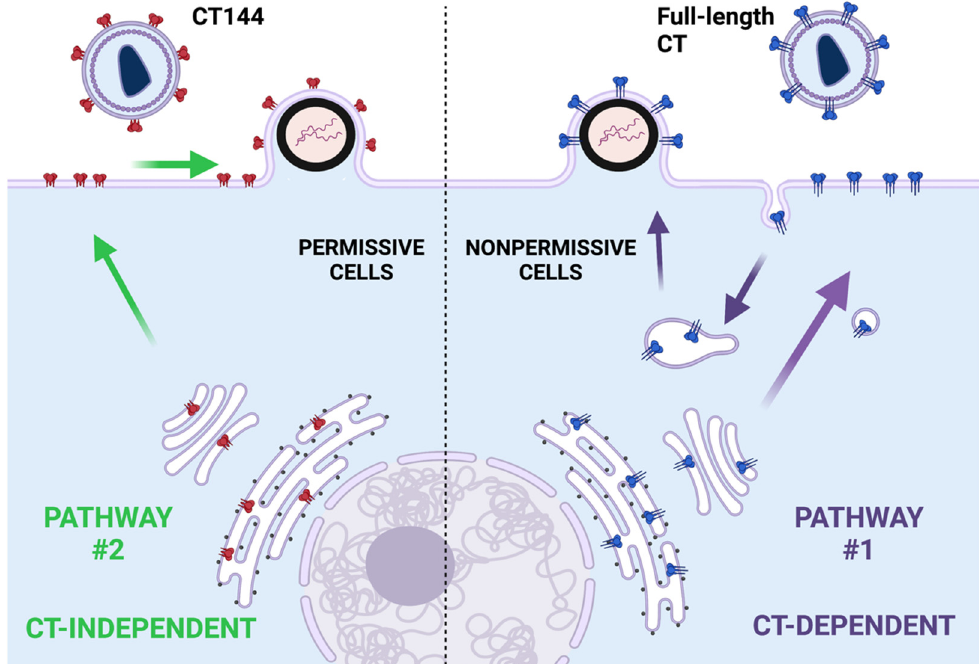
Figure 2. Schematic diagram outlining the existence of different pathways for Env available in nonpermissive vs. permissive cells. Nonpermissive cells exhibit a dominant CT-dependent pathway for incorporation of Env, while permissive cells allow either full-length CT or CT144 (truncated CT) Env to be incorporated. The CT-independent pathway is depicted as passive incorporation at the PM. The CT-independent pathway is lacking or blocked in nonpermissive cells.